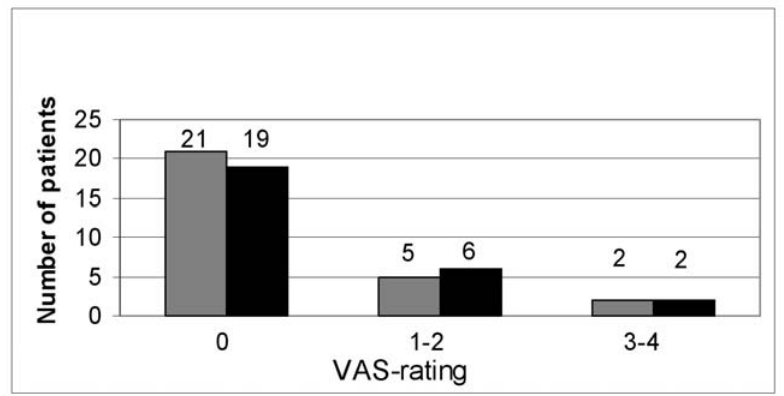
Fig. 2.a VAS-rating 30 minutes after removal of Laryngeal mask Airway (LMA) and Laryngeal Tube (LT), grey = LMA , black